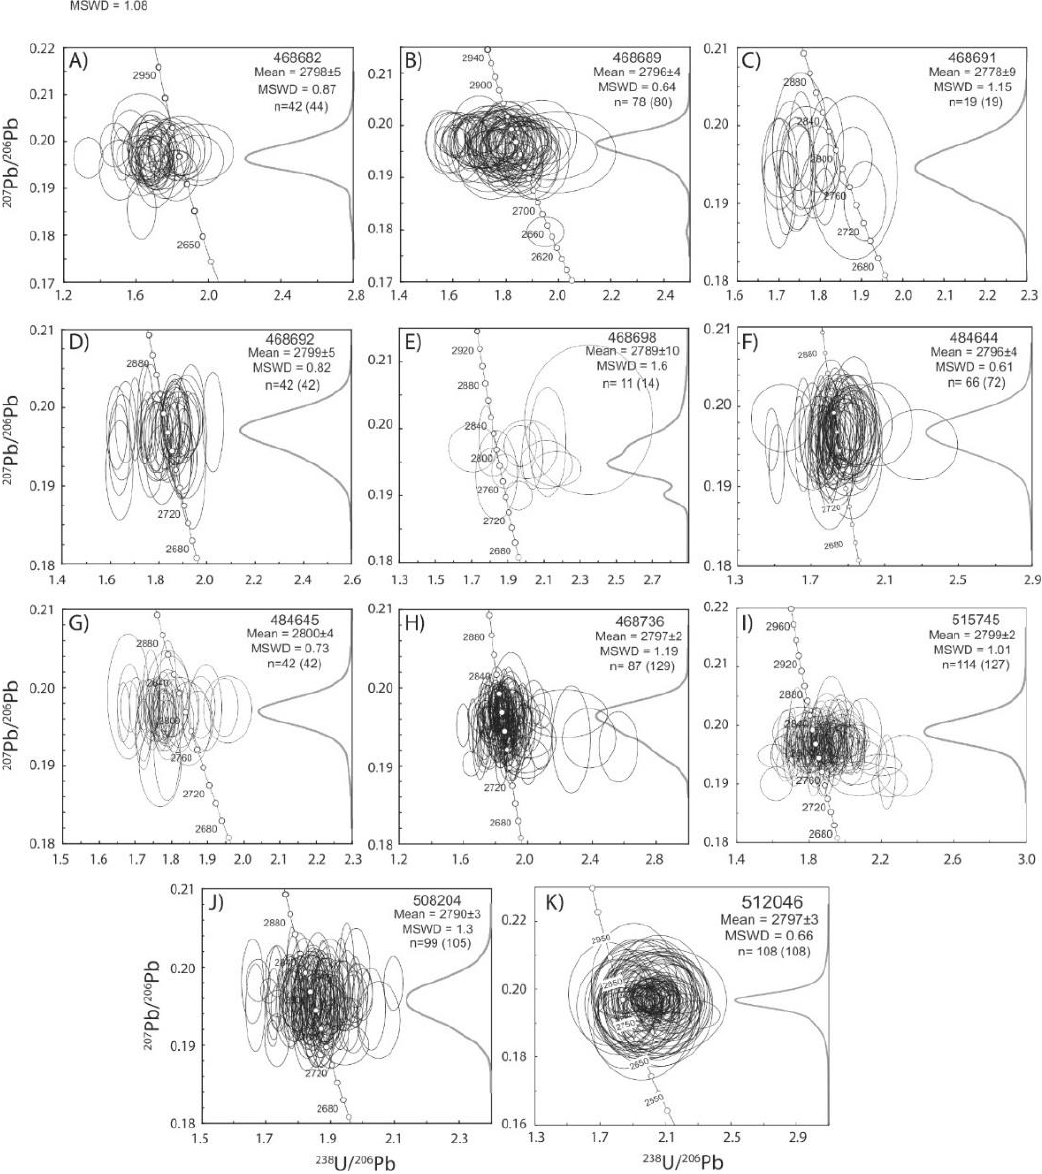
Figure 7. Zircon U-Pb Concordia diagrams. Mean ages in Ma are calculated as the weighted mean 207 Pb/ 206 Pb age. All samples have one main age population at ca. 2790 to 2800 Ma. Few inherited grains are observed in sample 468682. Error ellipses are on a 2 sigma level. Plotting ad calculations has been bone by Isoplot